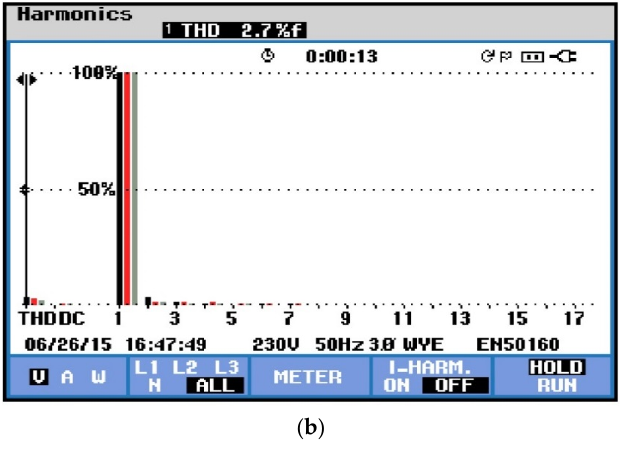
Figure 25. THD for the phase voltage of the three ‐ phase inverter with RL load for ( a ) simulation and ( b ) experimental.